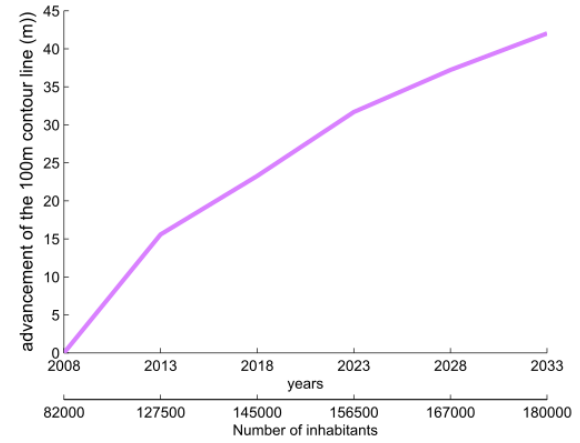
Figure 11. Advancement inland of the 100 m contour line of the seawater/freshwater interface with respect to the number of Lebanese and Syrian inhabitants and years.